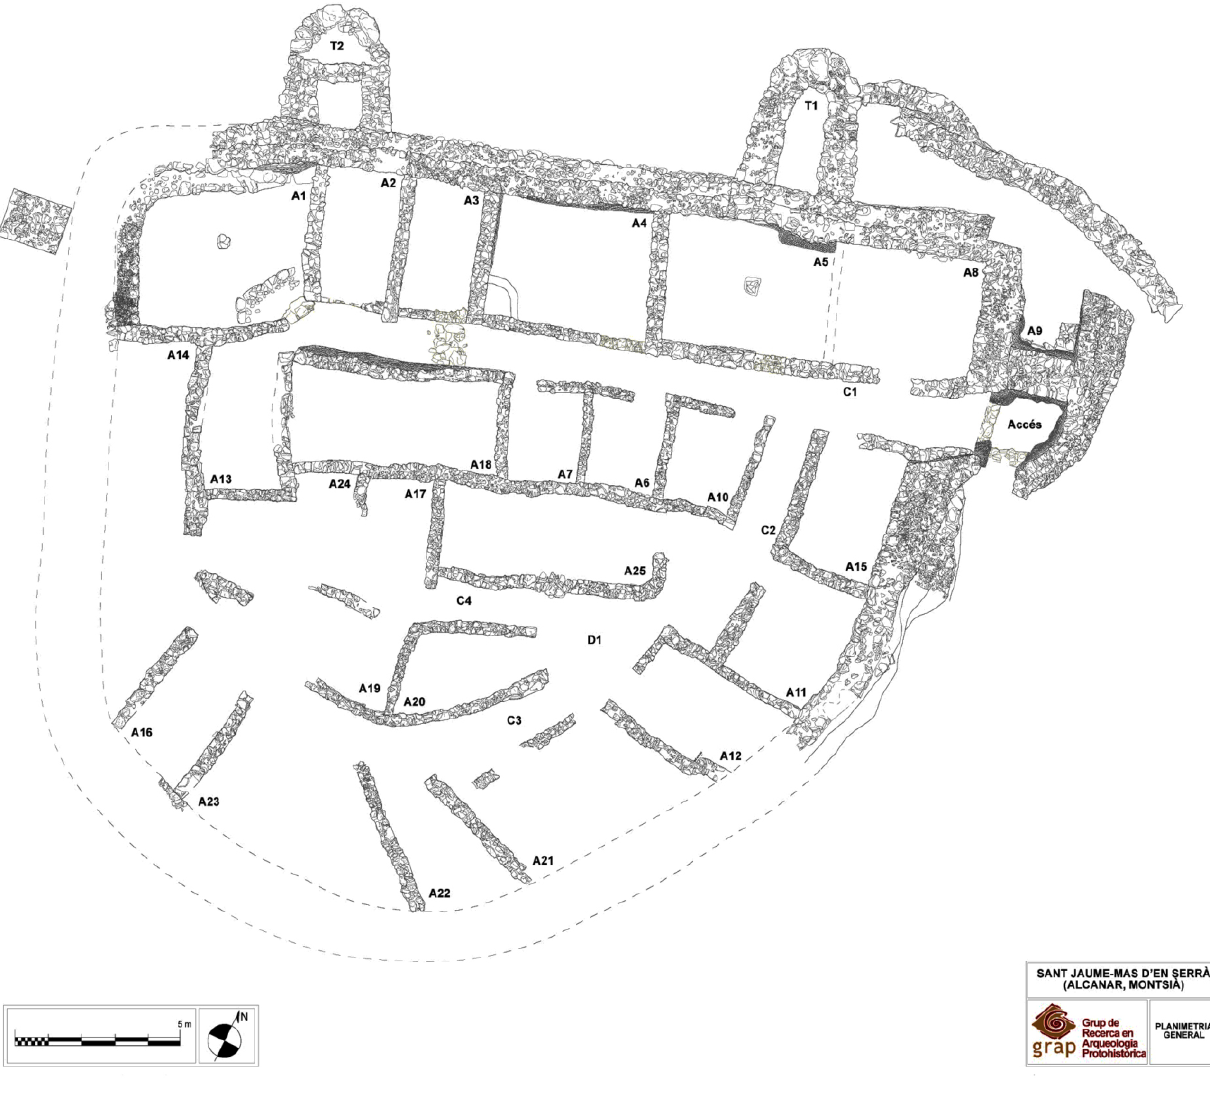
Figure 2. General plan of Sant Jaume.